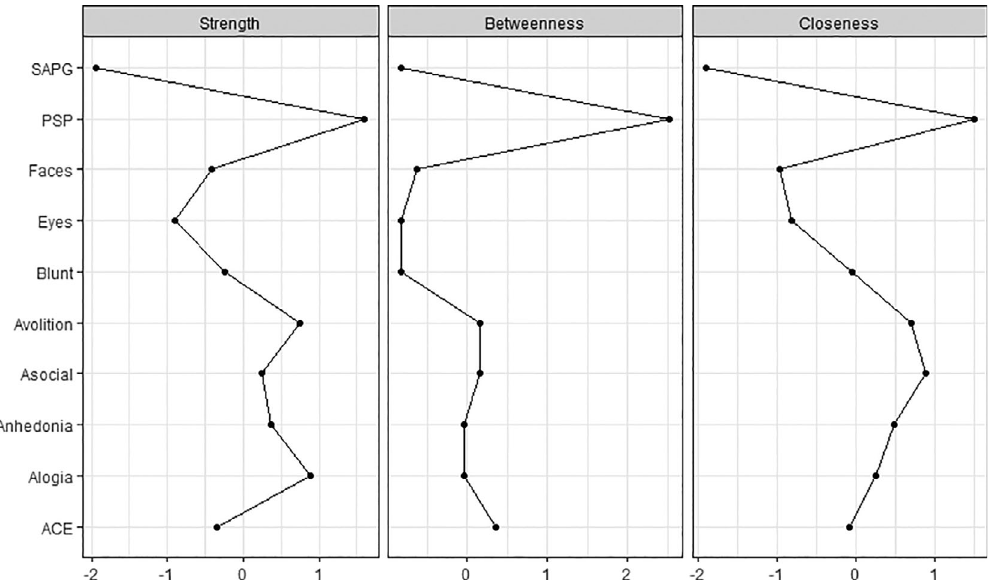
Figure 2. Centrality plots of functioning, symptoms, neurocognition and social cognition scores. ACE: Adden- brooke ’ s Cognitive Examination III; Asocial: asociality; Blunt: blunted affect; Eyes: Reading the Mind in the Eyes test; Faces: Faces test; PSP: Personal and Social Performance scale; SAPG: global Scale for the Assessment of Positive Symptoms